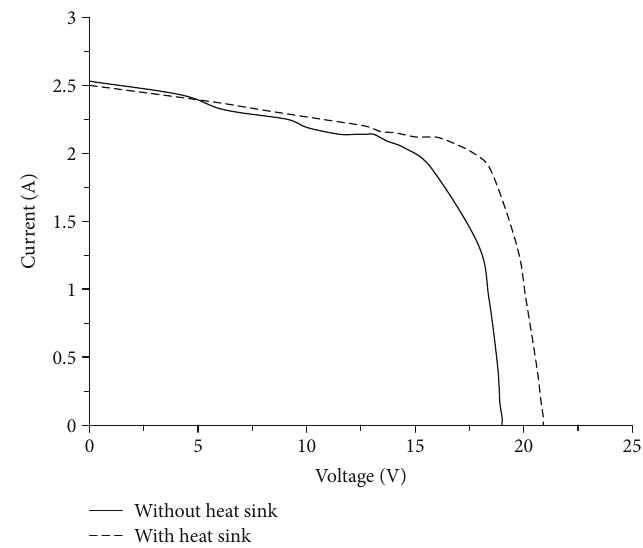
Figure 7: I-V curve of PV panel under irradiation of 1000W/m 2